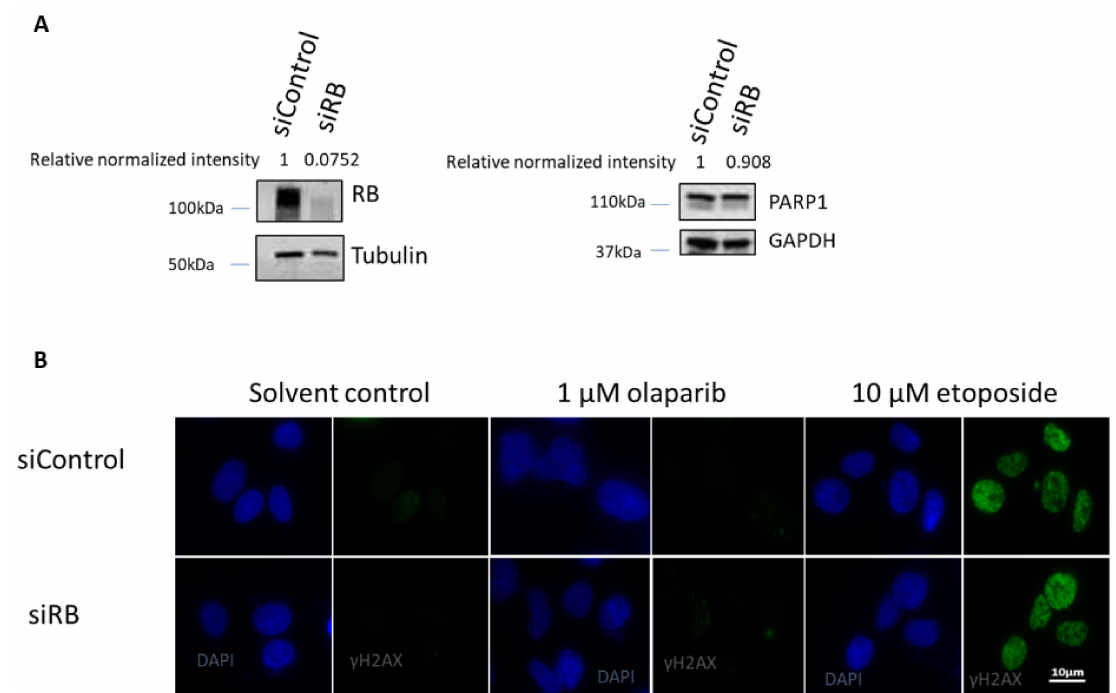
Figure 2. ( A ) RB was knocked-down efficiently three days after RB siRNA treatment, while PARP1 expression remained unchanged. GAPDH was used as the loading control. Western blot was repeated two times independently. Relative band intensities of RB and PARP1 are shown by normalizing with tubulin and GAPDH, respectively. ( B ) Immunofluorescence staining of γ H2AX foci (green) in RB knocked-down cells (siRB) and control siRNA-treated cells (siControl) after treating with solvent control, 1 µ M olaparib or 10 µ M etoposide for one hour. Nuclei were stained with DAPI (blue). Immunofluo- rescence staining was repeated two times independently. Quantification of cells showing more than five γ H2AX per cell is shown in Supplementary Figure